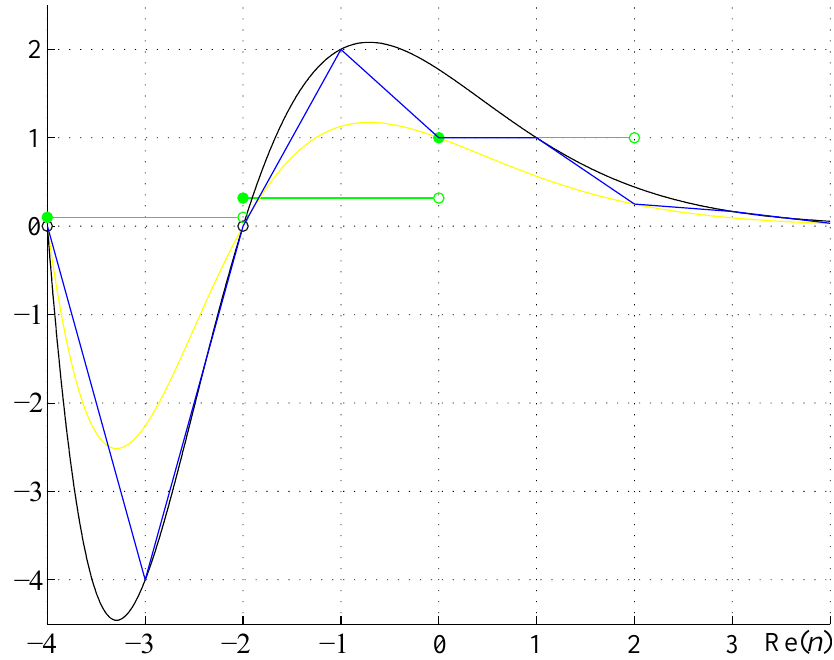
−4 Figure 3. n -ball diameter recurrence relation g n for n  ℤ (blue); even (yellow) and odd (black) Figure 3. n -ball diameter recurrence relation g n for n ∈ Z (blue); even (yellow) and odd (black) algebraic forms of g n , and the π ˆ (cid:98) n /2 (cid:99) factor (green) for − 4 ≤ n ≤ 4, n ∈ C algebraic forms of g n , and the π^ ⌊ n /2 ⌋ factor (green) for − 4 ≤ n ≤ 4, n  ℂ .